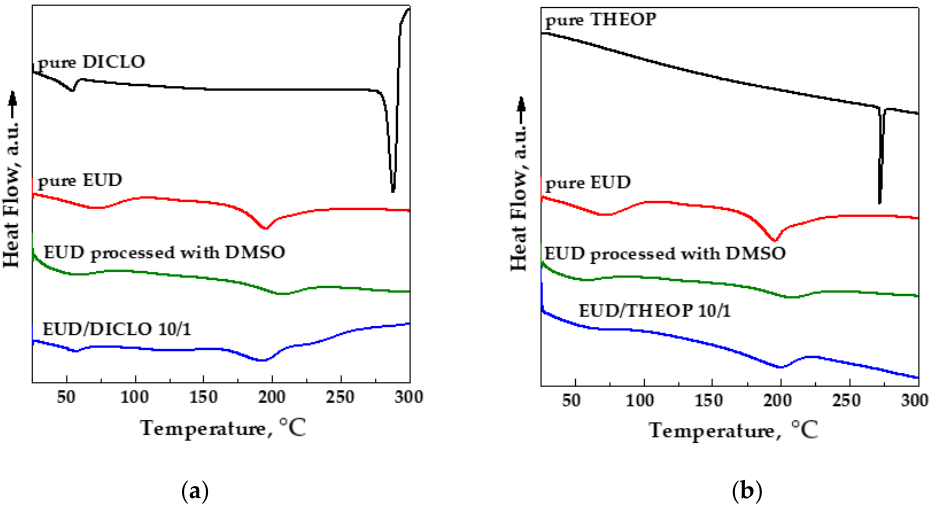
Figure 12. DSC thermograms of unprocessed and SAS processed EUD, unprocessed drugs, and SAS processed EUD / drug coprecipitated powders. ( a ) DICLO; ( b )